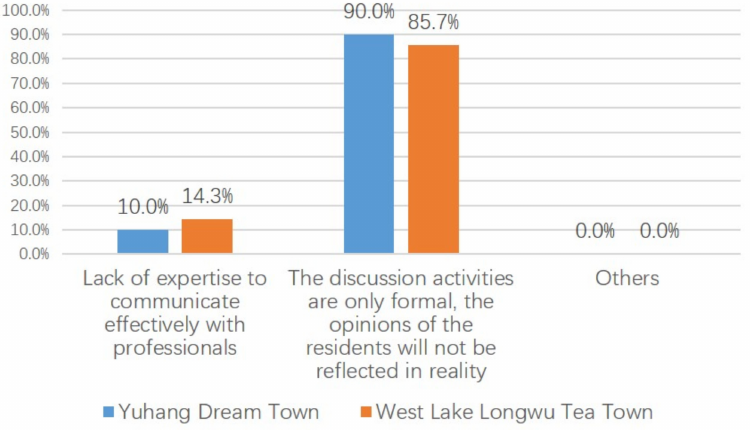
Figure 26. Reasons why respondents are reluctant to participate in discussion activities on the planning and construction of the local CT practice (source: